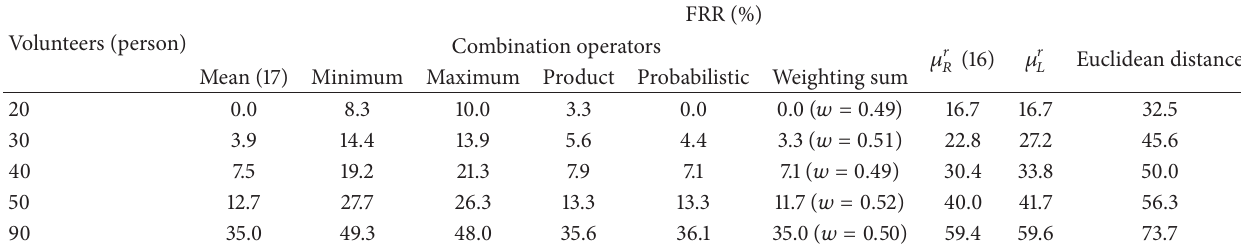
Table 4: FRRs in identification of combination operators.